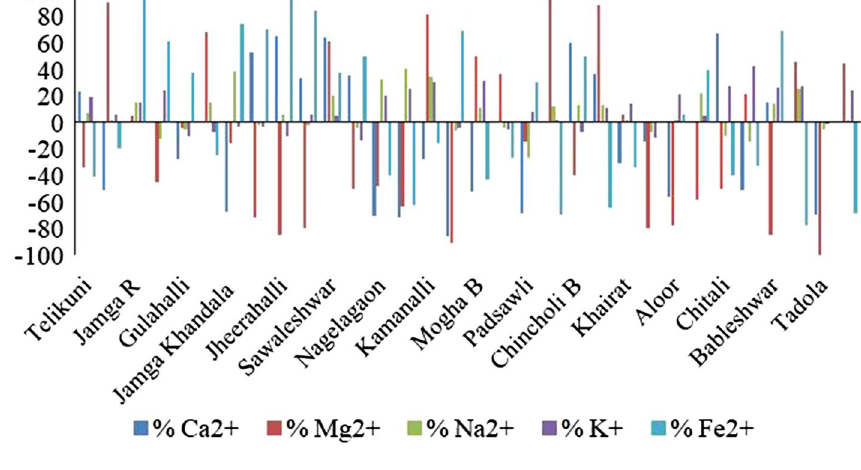
Fig. 43 Relationship between the maximum rainfall and nega- tive ions of both the